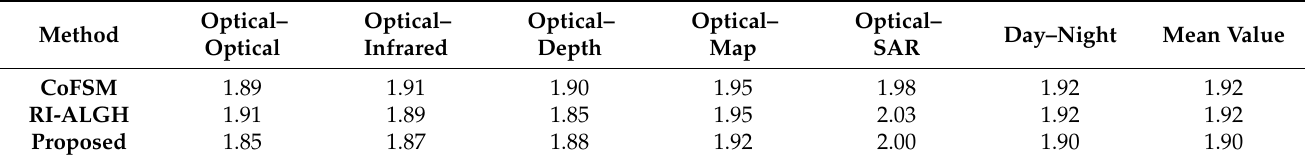
Table 5. Quantitative evaluation results for each method. Table 6. RMSE evaluation results for each method